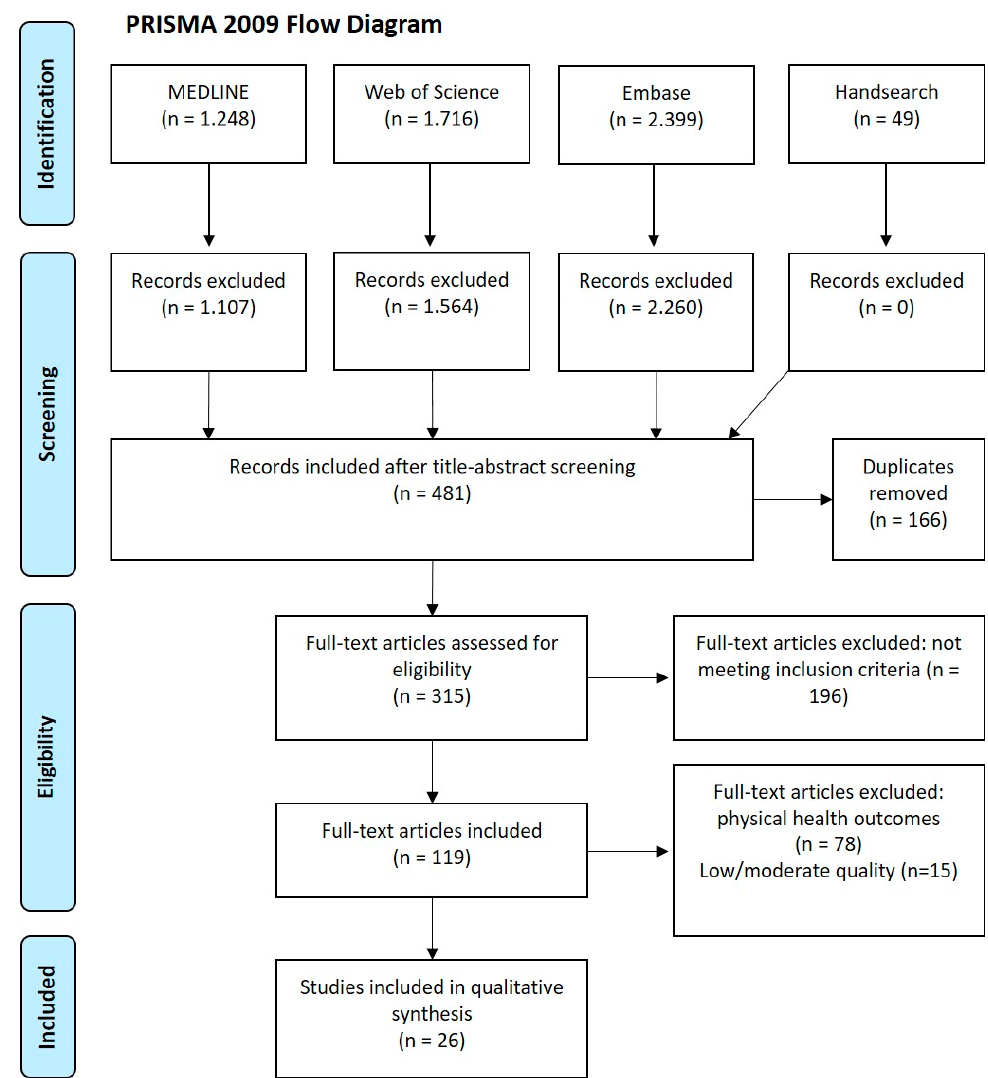
Figure 1. Prisma Flow Chart showing the selection process of studies on mental health in the self-employed versus employees [28].